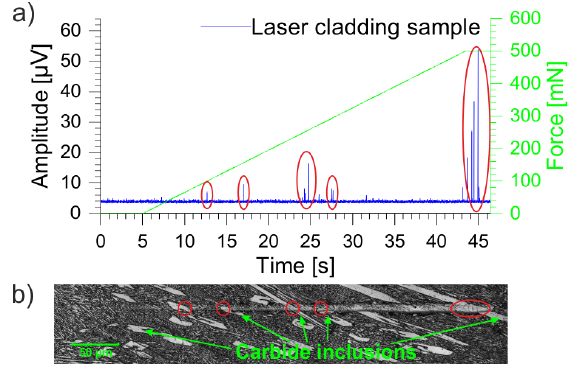
Figure 5. Laser cladding sample: a) AE envelope graph and b) surface image with marked areas of cracks (bright spots represent carbide